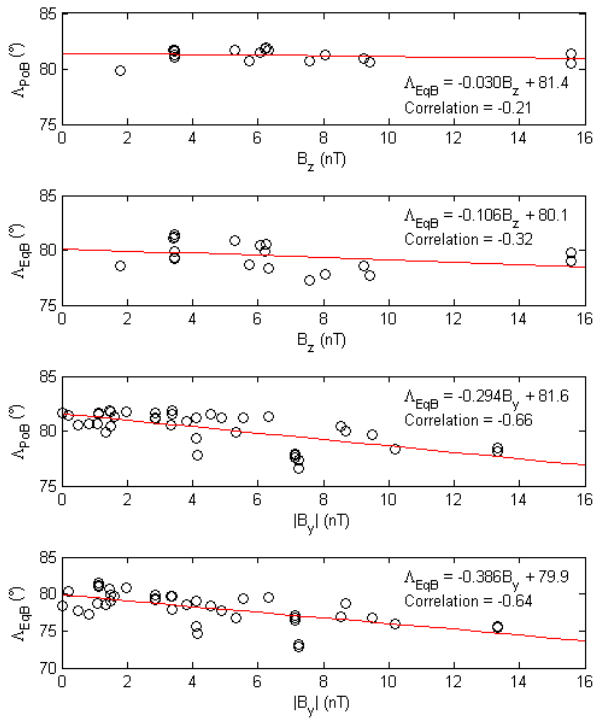
Fig. 17. Invariant latitude of the cusp poleward and equatorward boundary as a function of B z (two first panels) and | B y | (two last panels), all for steady and northward